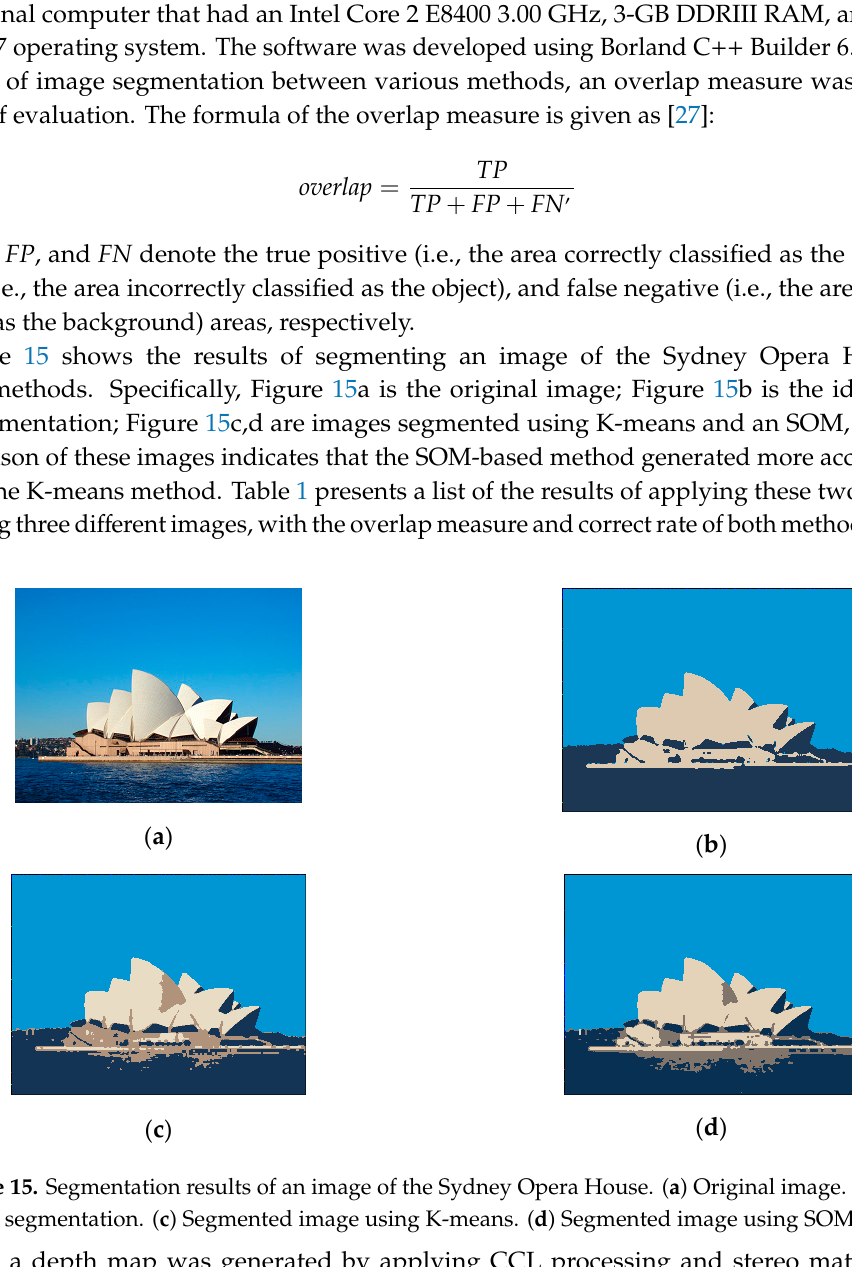
(e) Figure 16. Results of the proposed stereo vision method. ( a ) Left image. ( b ) Right image. ( c ) Image after color classification. ( d ) Image after CCL. ( e ) Depth map.